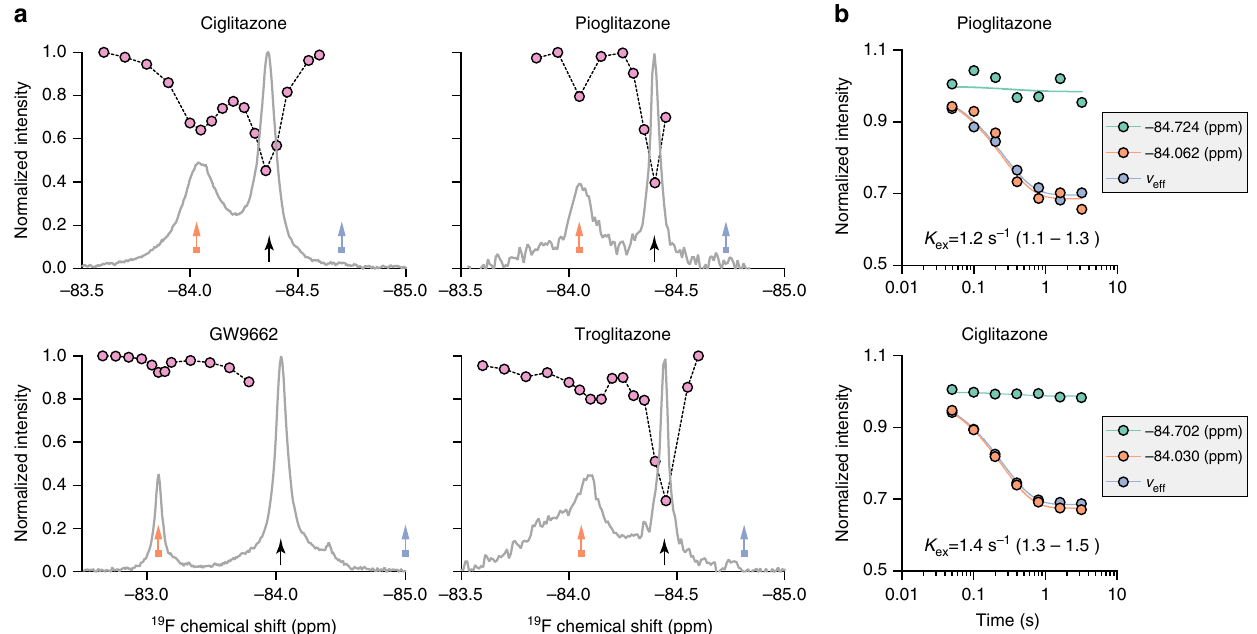
Fig. 5 Chemical exchange saturation transfer indicates slow exchange between multiple helix 12 conformations. a A selective Gaussian pulse was used to saturate the 19 F spectra bound to the indicated ligands at locations indicated by pink circles. The height of the pink circles indicates the height of the peak indicated by the black arrow when the selective pulse was carried out at the chemical shift of the pink circle. If exchange is occurring between the two peaks, the pink dots should mirror the spectrum. b A selective Gaussian pulse was used to saturate the spectrum at an on resonance ( a ; orange box arrow) and off resonance ( a ; blue box arrow) location, the peak height of the most abundant resonance ( a ; black arrow) was monitored as a function of the duration of the saturation pulse, and the resulting peak intensities were fi t to extract the exchange rate. Ninety- fi ve percent con fi dence intervals for the fi t of the calculated exchange rates are shown within parentheses. PPAR γ K502C -BTFA was used for these data, except for ciglitazone which used PPAR γ C313A, K502C -BTFA for increased signal to noise. These experiments were performed